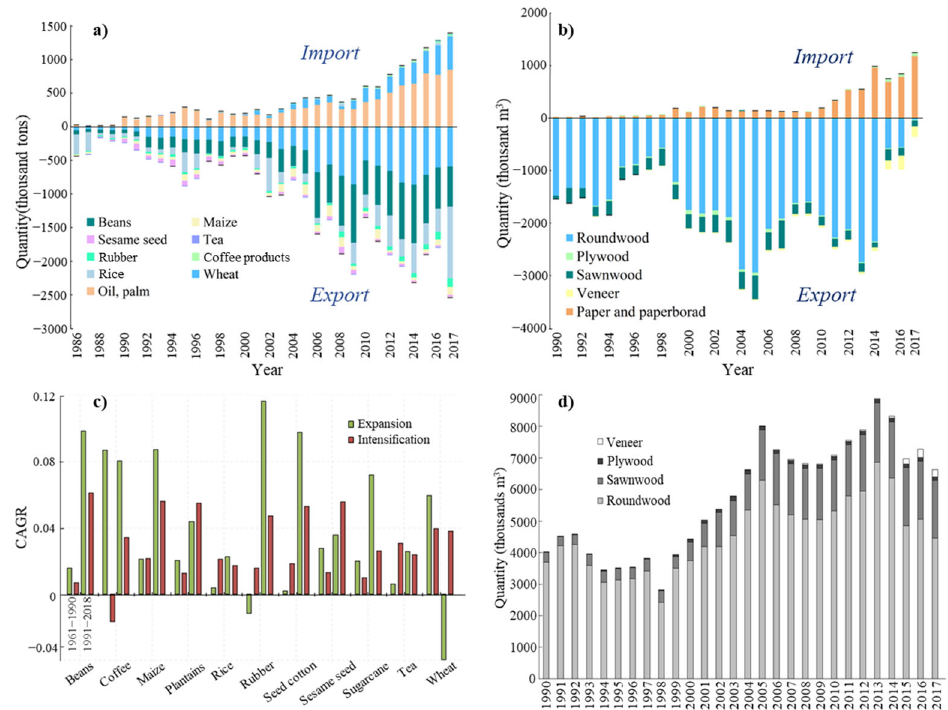
Figure 8. Production and trade of agricultural and forest products in Myanmar. ( a ) Import and ex ‐ port of agricultural products between 1986 and 2017, ( b ) import and export of forest products be ‐ tween 1990 and 2017, ( c ) compound annual growth rate of expansion and intensification for the main crops in Myanmar during the periods of 1961–1990 and 1991–2018, ( d ) volume of the main four forest products annually produced in Myanmar between 1990 and 2017. These historical data are acquired from the Food and Agriculture Organization (http://faostat.fao.org/(accessed on 25 June